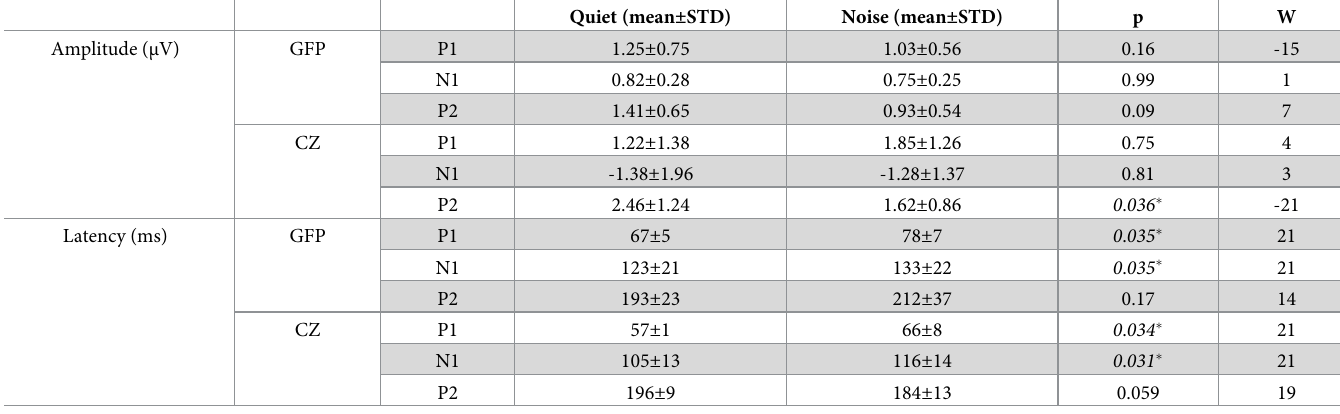
Table 2. Results of Wilcoxon comparisons between quiet and noise for GFP and Cz responses for the NH control group.